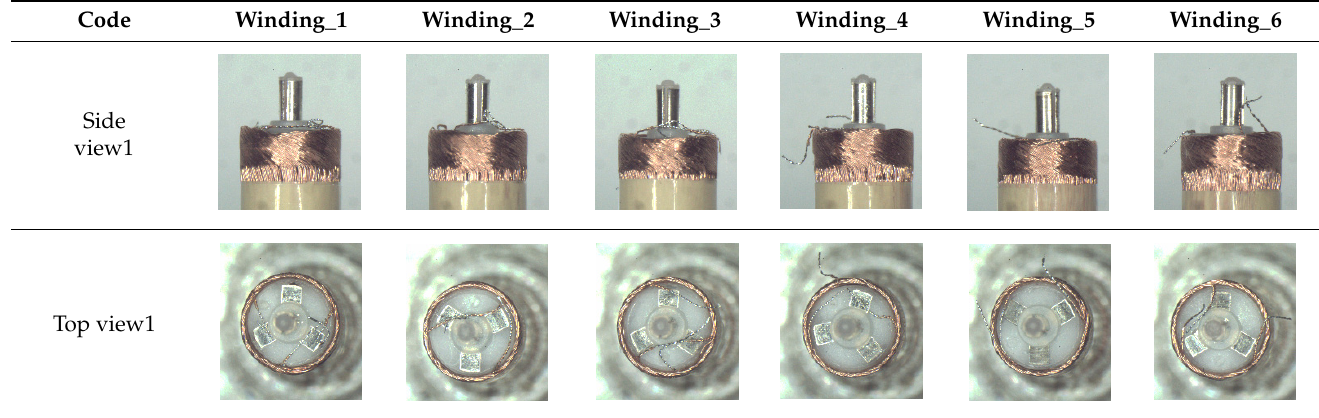
Table 11. Brushing results under the composition mode of horizontal brushing and vertical brushing.